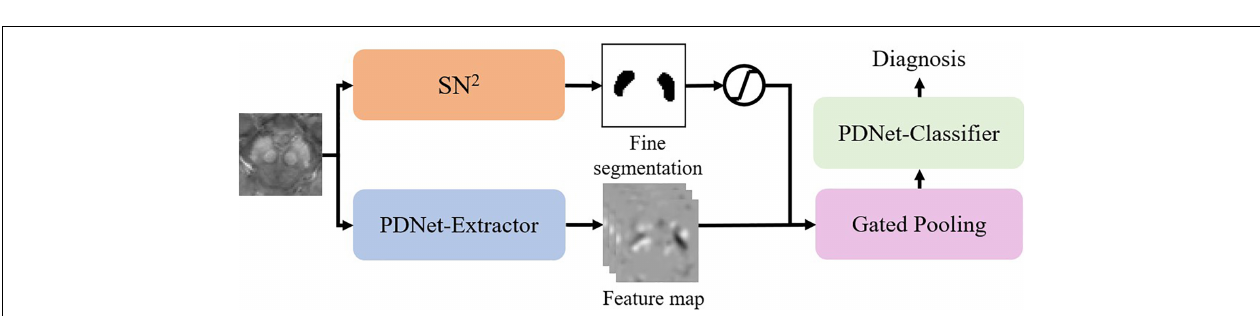
matrix, n = 384; and neighborhood gray-tone difference matrix, n = 120. Detailed descriptions of these radiomics features